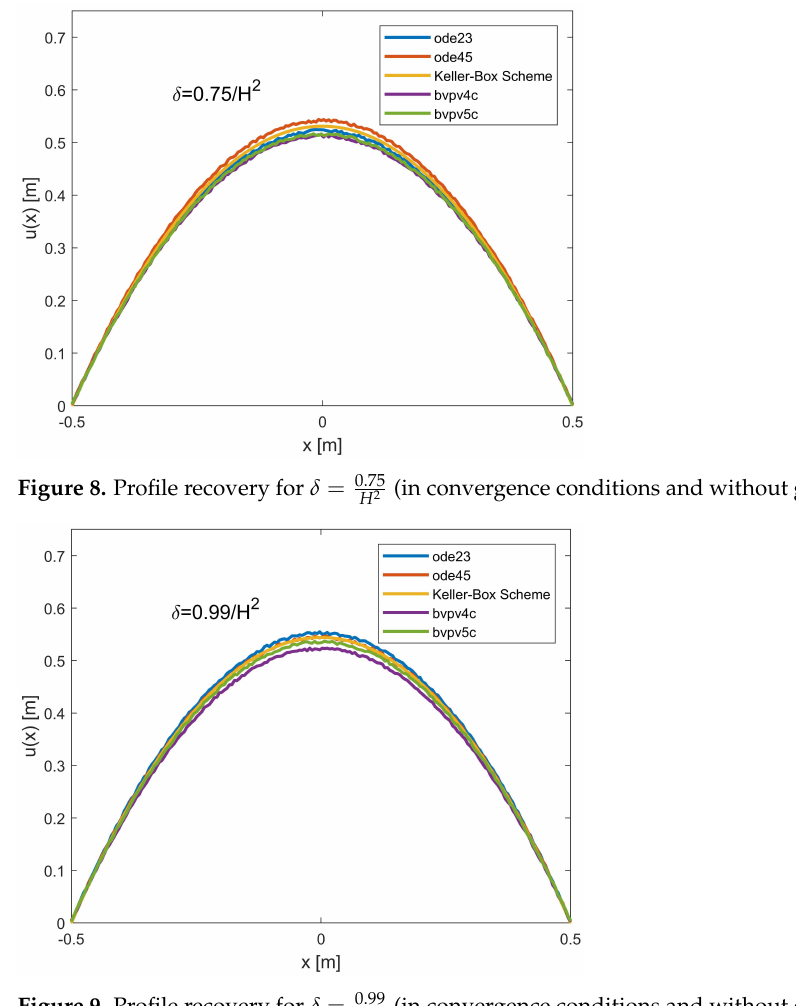
(in convergence conditions and without ghost H 2